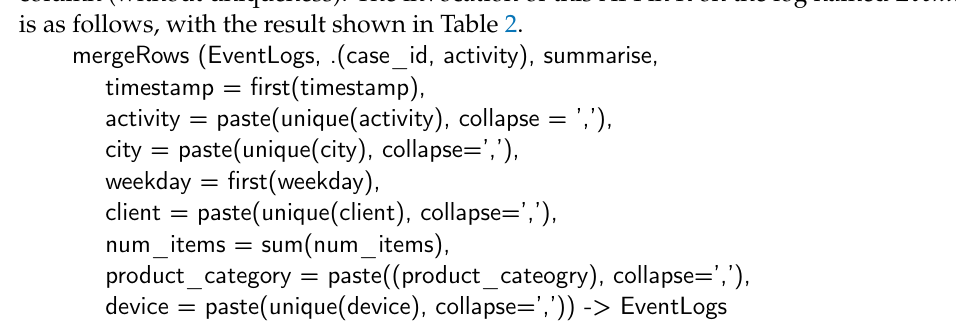
Table 2. Event log after merging the first three rows of Table 1 into one row, in gray.